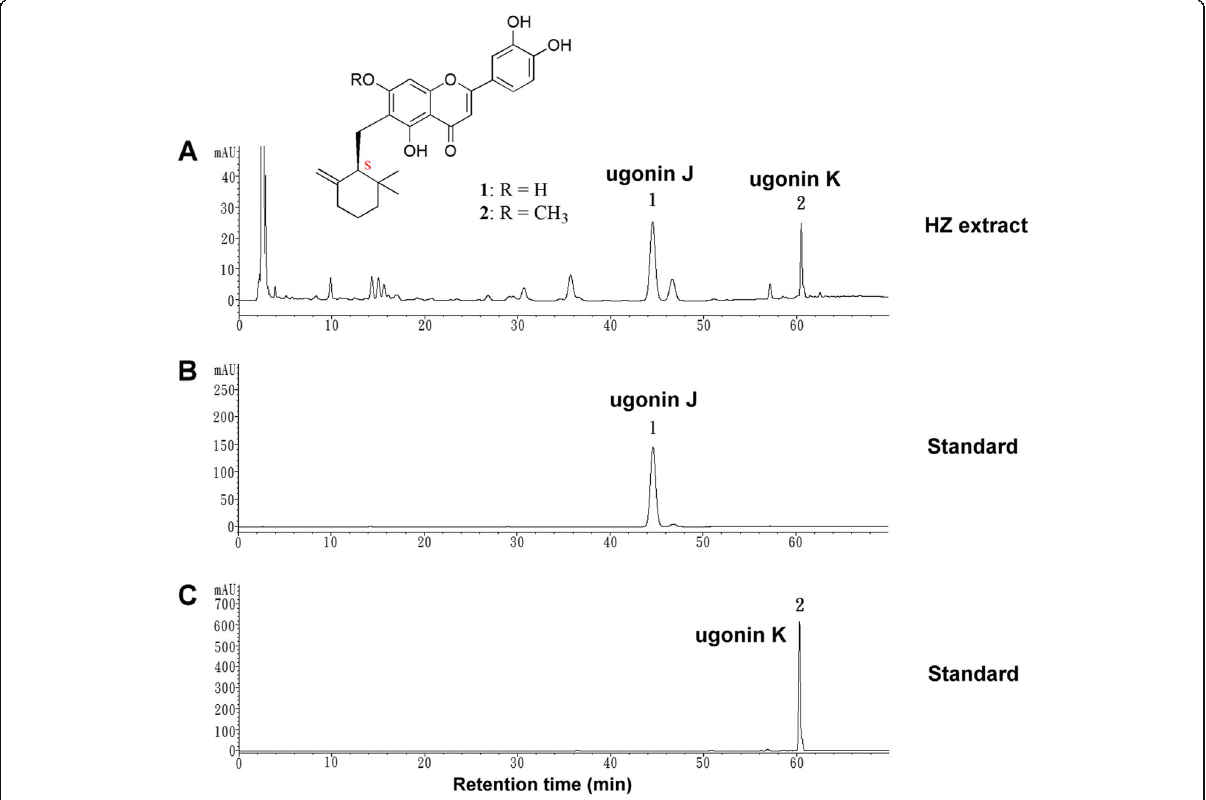
Fig. 1 Characterization of HZ extract. a HPLC chromatograms of HZ extract. Two major peaks were identified in the HZ extract. b Ugonin J and ( c ) ugonin K were used as standards. The chemical structures of the ugonins are